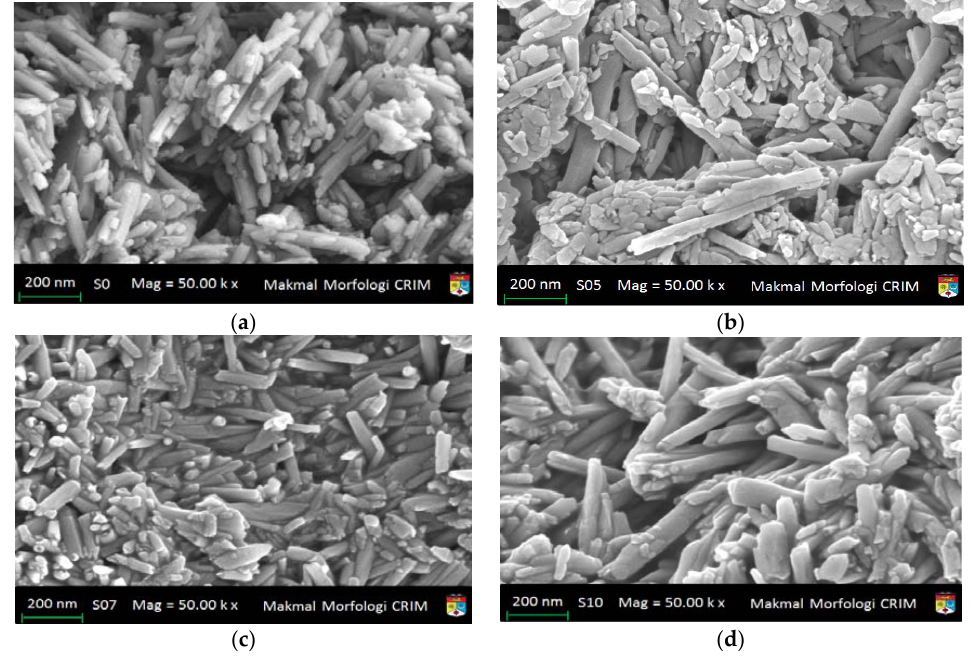
Figure 2. FESEM microphotographs for: ( a ) S0; ( b ) S05; ( c ) S07; and ( d )